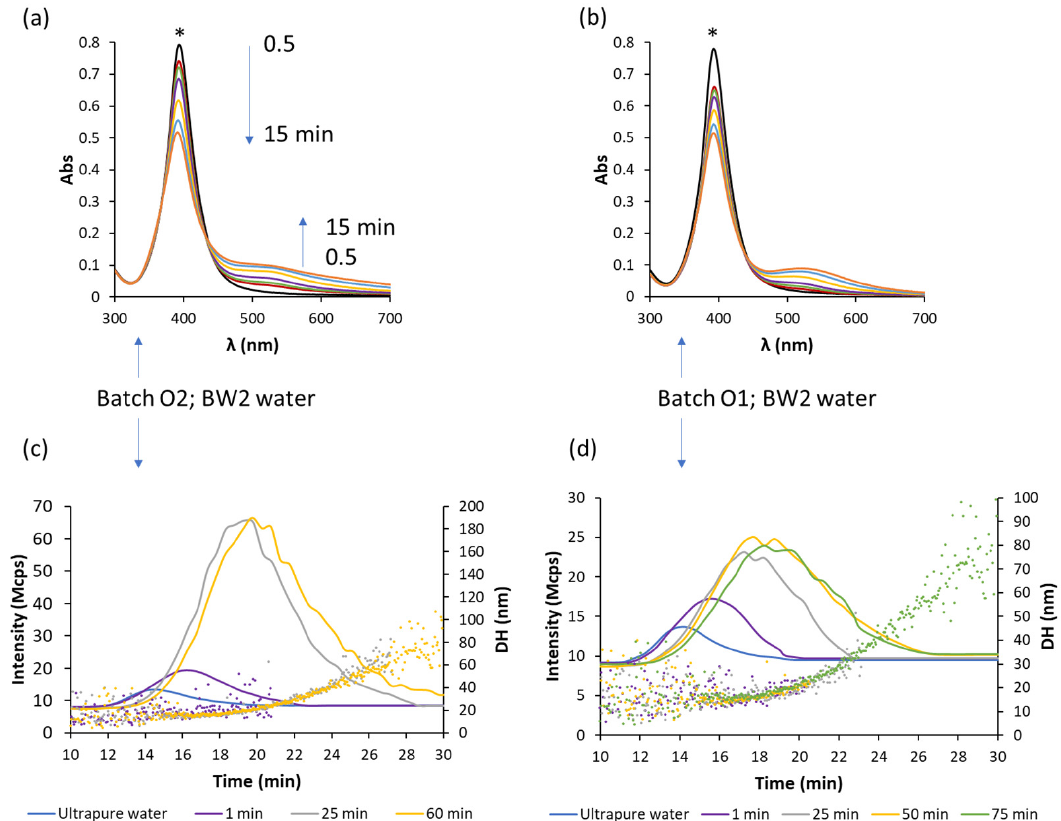
Figure 3. Spectra of batches O2 ( a ) and O1 ( b ) diluted 1/4 with bottled mineral water measured at several times (0.5, 1, 2, 5, 10, 15 min, the SPR band for the dilution with ultrapure water was also included, marked with *) and their fractograms (solid lines) ( c ) and ( d ), respectively, by using dynamic light scattering (DLS) and hydrodynamic diameter (points) measured at different times.